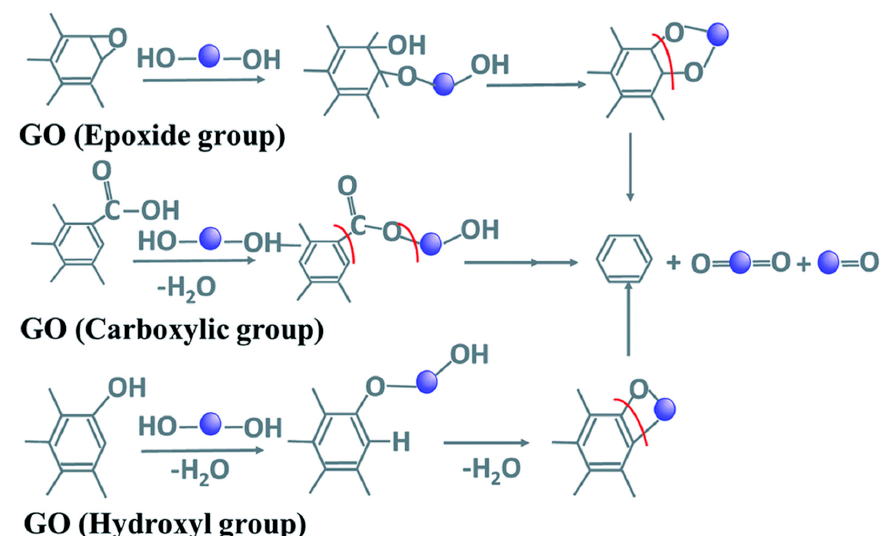
Figure 6. Reduction of oxygen functionality in GO by plant extracts. Adapted with permission from Bhattacharya, et al. [101] under Creative Commons Attribution 4.0 International.